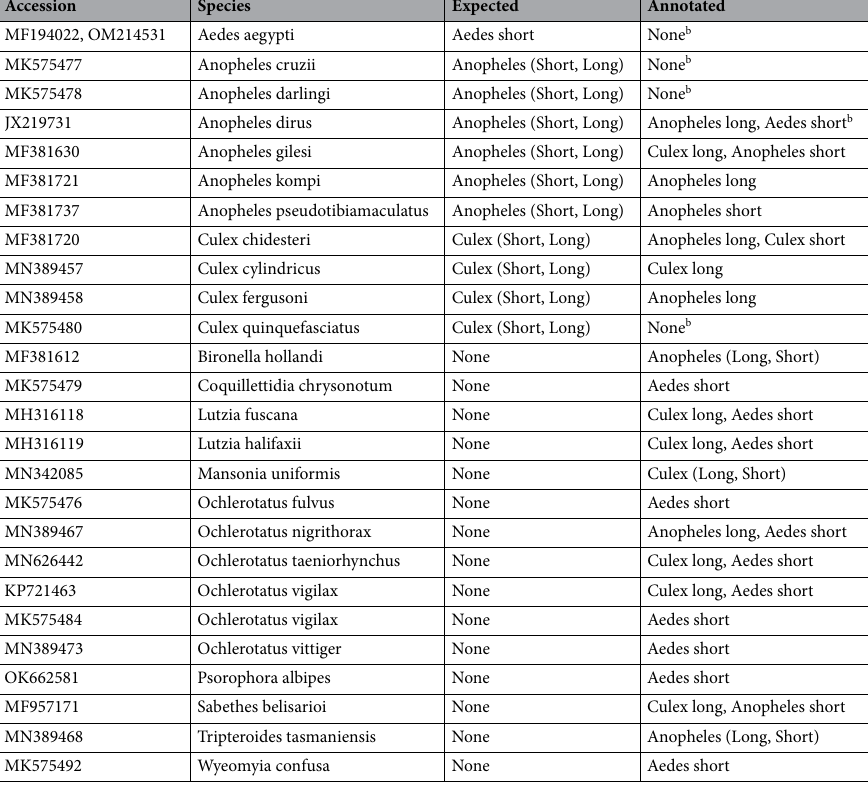
Table 4. Control Region sequences which were annotated with motifs from different genera, or incompletely a . a Expected motifs are the motifs expected to be found in the region 80–210 bp upstream of the 12S rRNA gene, and Annotated motifs are the motifs annotated by MAST in that region. b Other complete mitogenome sequences from the same species had the expected GSMs. This table includes 27 of the 472 (5.7%) sequences